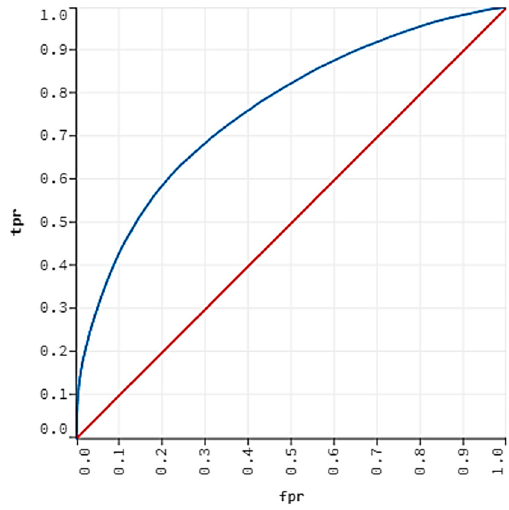
Figure 5. ROC curves for the GBM model.